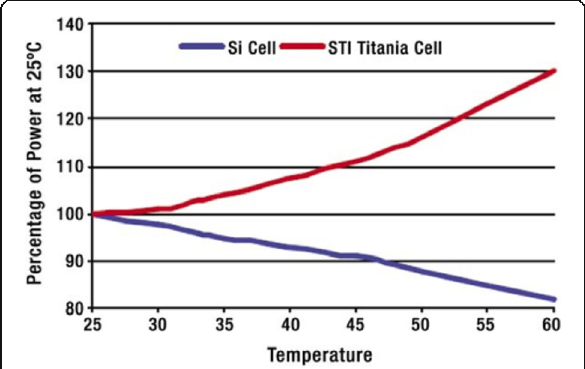
Fig. 1 The performance of dye PV modules increases with temperature, contrary to Si-based modules [(Web reference [available online at http://www.sta.com.au/downloads/DSC%20Booklet.pdf] [11,